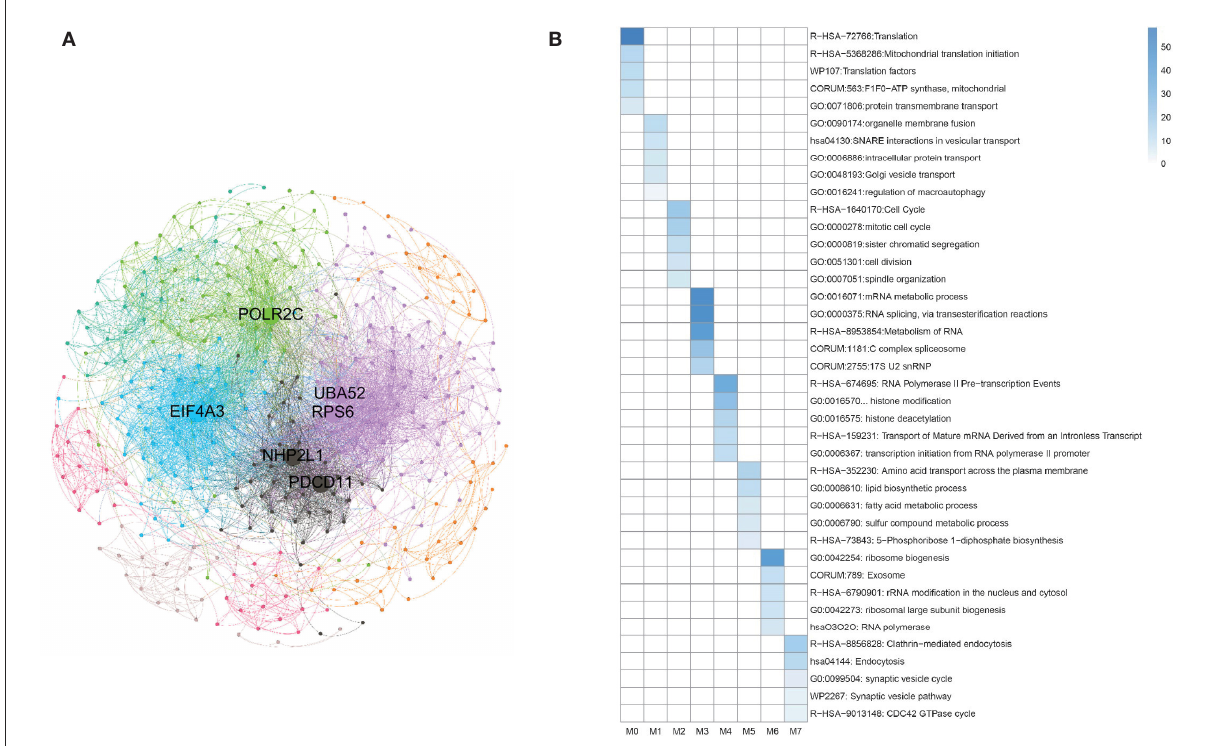
FIGURE9 Clustering analysis for matched homologous genes in human. (A) Topological organization for eight modular sub-networks marked with different colors. (B) Enrichment biological functions of pan-cancer sub-networks. Each row represents a GO BP term and each column corresponds to a pan-cancer sub-network for each